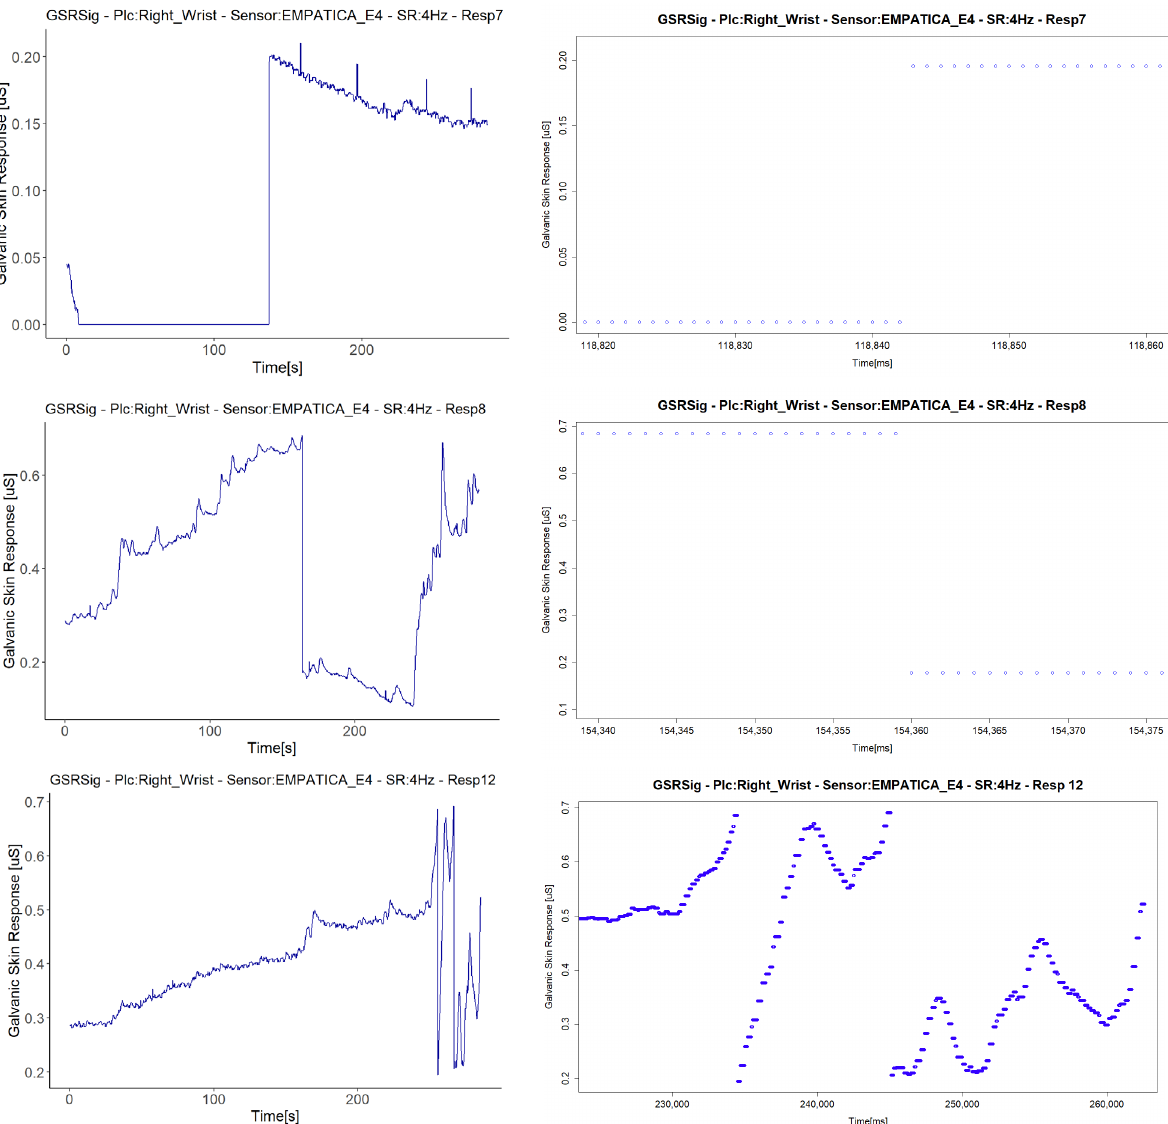
Figure 11. Illustration of cases with fall to zero anomalies detected. On the left are the signals with anomalies, while on the right are the other signals measured in the same respondent with the same sensor type.